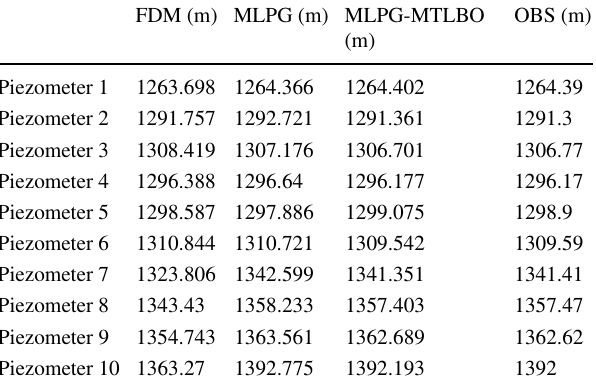
Table 5 Groundwater table at the end of last month of simulation